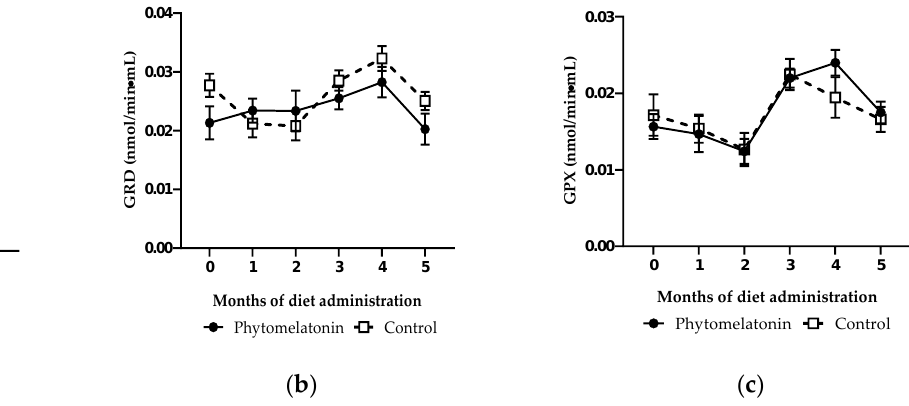
Figure 2. Monthly variations of catalase (CAT), ( a ), glutathione reductase (GRD), ( b ) and glutathione peroxidase (GPX), ( c ) activities in seminal plasma of animals fed with a phytomelatonin-rich ( • ) or commercial (control, □) diet from month 0 (before diet administration) to month 5. Values are shown as mean ± S.E.M., n = 16.